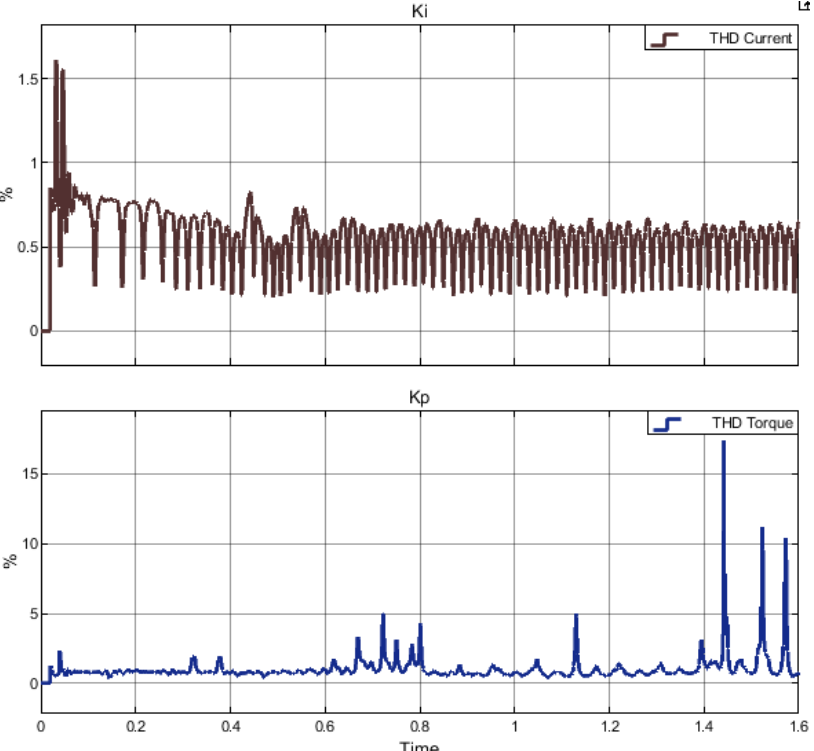
Figure 10. Change in harmonic distortion coefficient K I and electromagnetic moment ripple coeffi- cient Σ K p during short-circuit modeling in phase A-B at the time t = 0.8 s in the steady state.